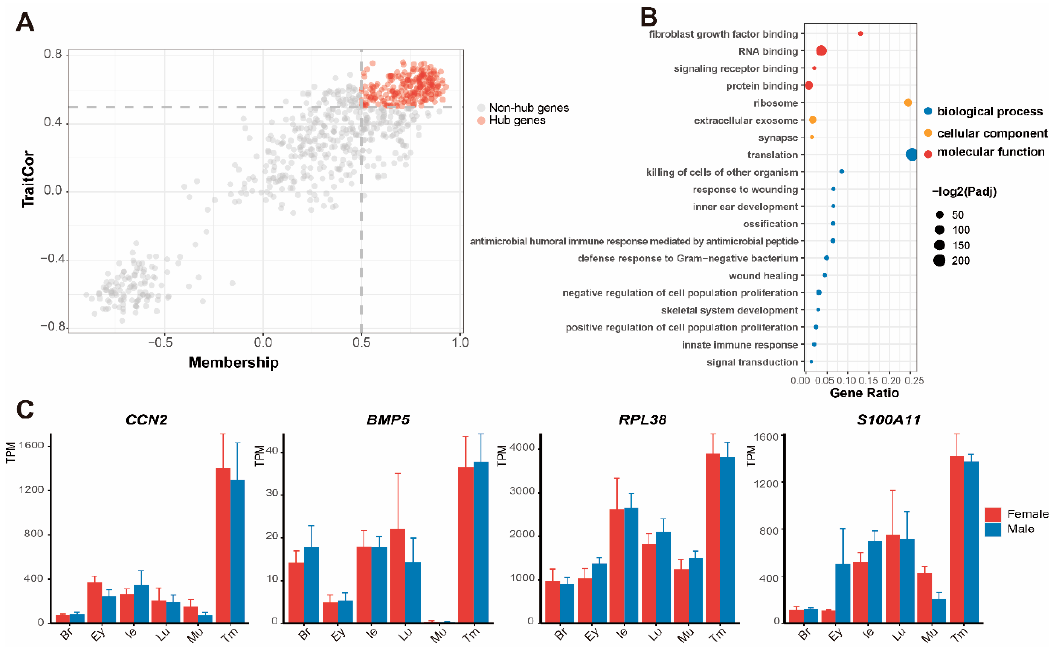
Figure 4. Enrichment analysis and expression of hub genes related to the tympanic membrane. ( A ) Selection of hub genes in the dot plot. ( B ) Main Gene Ontology (GO) functional items enriched based on hub genes (Padj = corrected p -value). ( C ) Expression patterns of four featured genes in the six tissues.